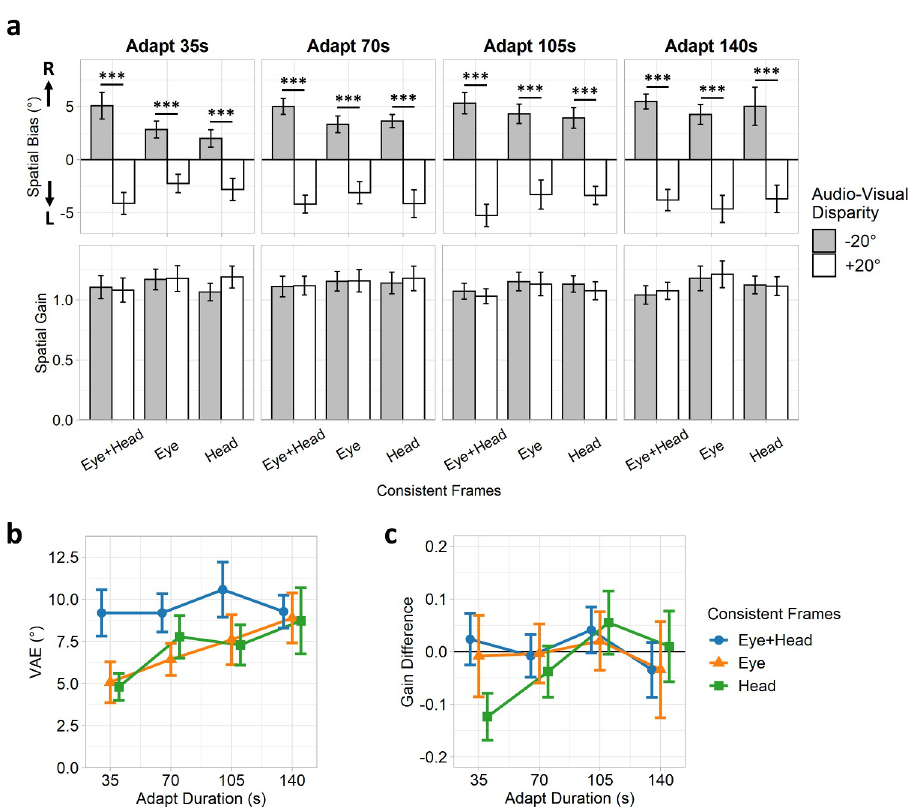
Fig 2. Experiment 1: Group spatial bias and gain estimates. (a) Spatial bias (intercept) and gain (slope) coefficients for each condition. Error bars indicate standard errors of the coefficients. (b) VAE magnitudes and (c) gain differences, quantified by contrasting spatial bias and gain coefficients between adaptation disparities (-20˚ > +20˚). Positive VAE magnitudes indicate spatial recalibration in the direction of the visual offset. Error bars indicate standard errors of the